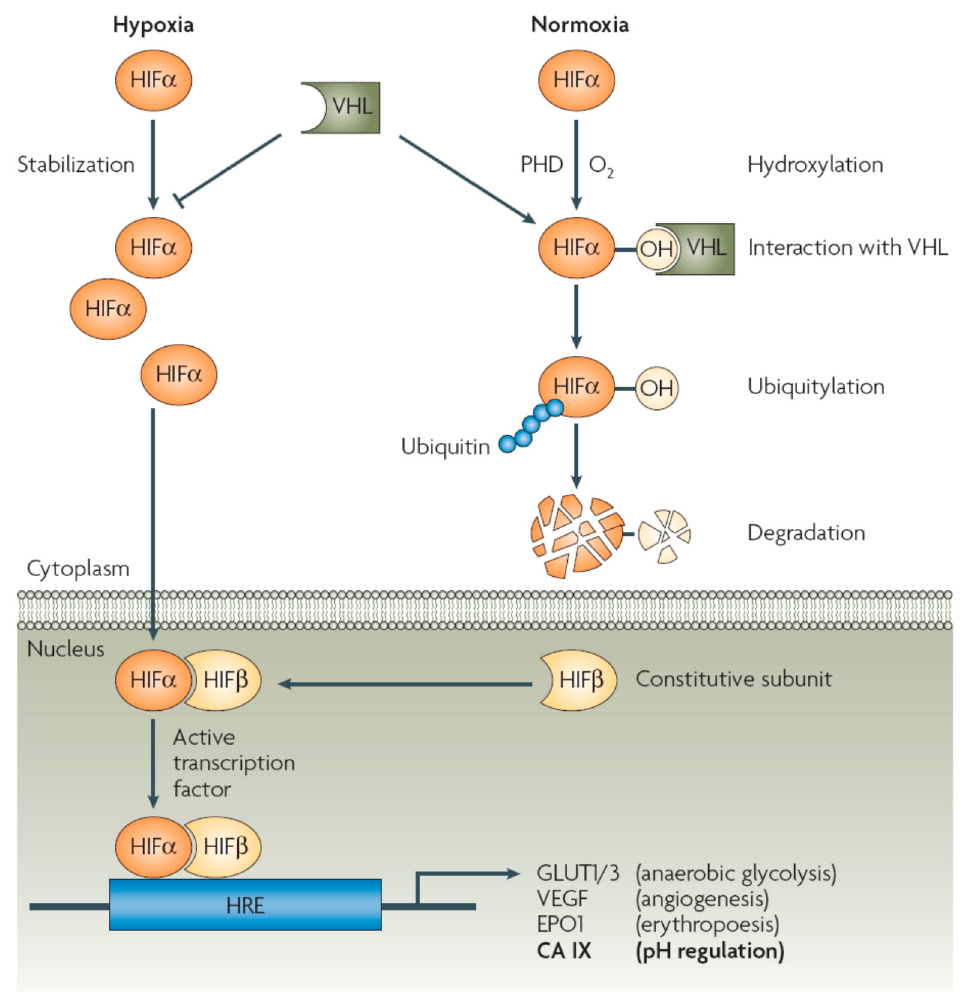
Figure 1. Mechanism by which the transcription factor HIF-1 α (abbreviated as HIF α ) orchestrates the overexpression of proteins involved in aerobic glycolysis, angiogenesis, erythropoesis and pH regulation in hypoxic tumors. In normoxia HIF α is hydroxylated at a Pro residue and targeted for degradation by the proteasome (PHD, prolyl-hydroxylase; VHL, von Hippel-Lindau factor, HRE, hypoxia responsive element). In hypoxia, its accumulation leads to overexpression of the proteins involved in tumorigenesis mentioned above [5–8].